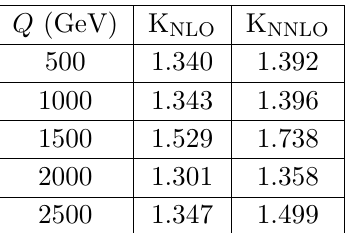
Figure 3 . The K-factors up to NNLO in QCD for RS model (left panel) and for the signal (right panel).